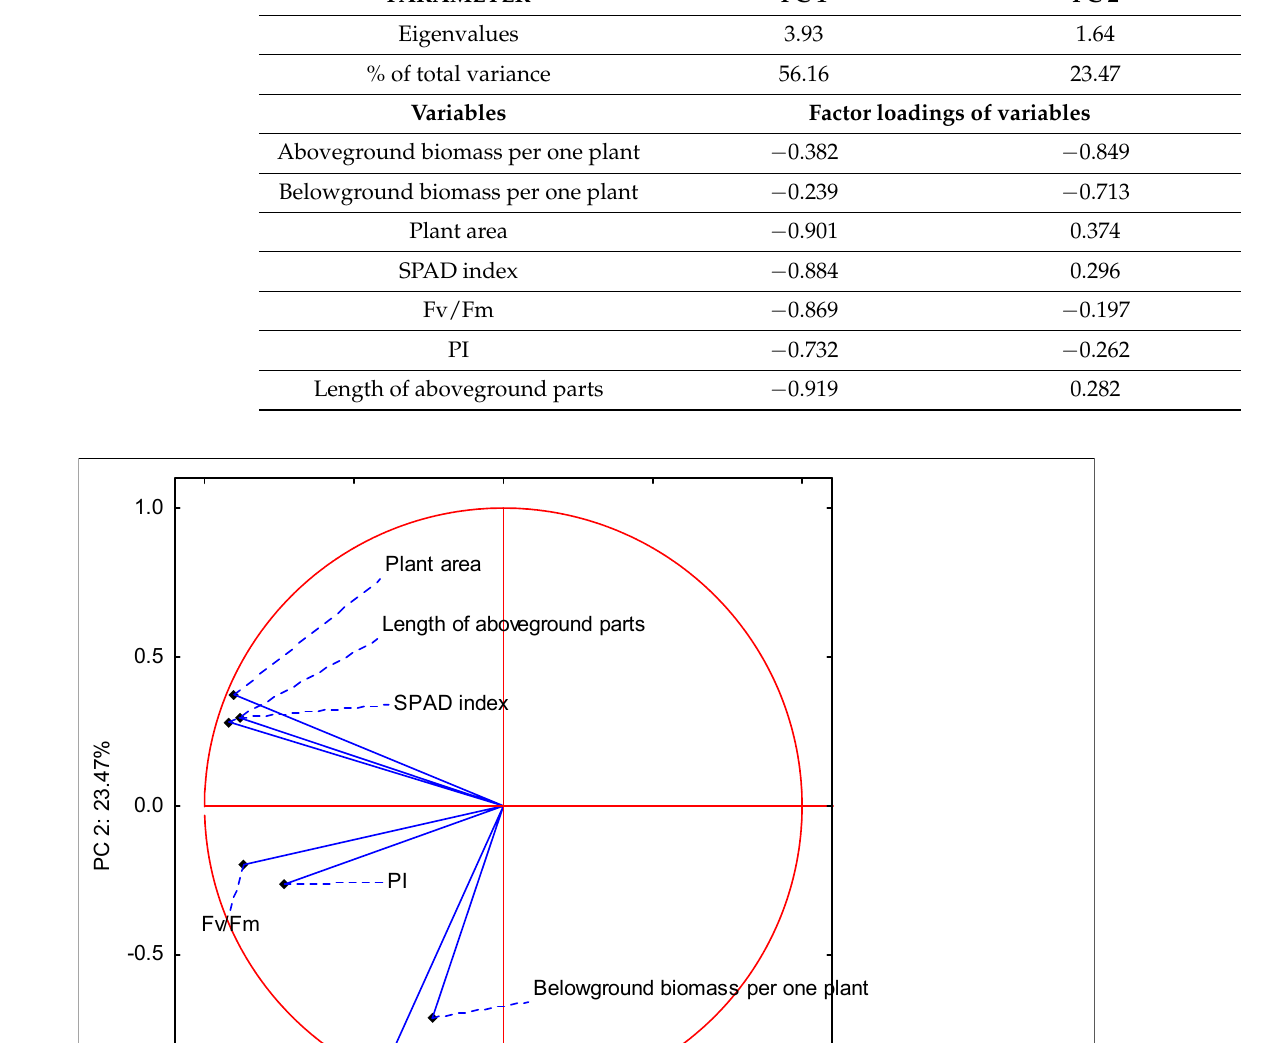
Table 4. Set of eigenvalues together with percentage share of total variance of principal components and factor loading of variables for PCA taking into account the growth and physiological traits of herbicide-susceptible and -resistant biotypes of wild oat.